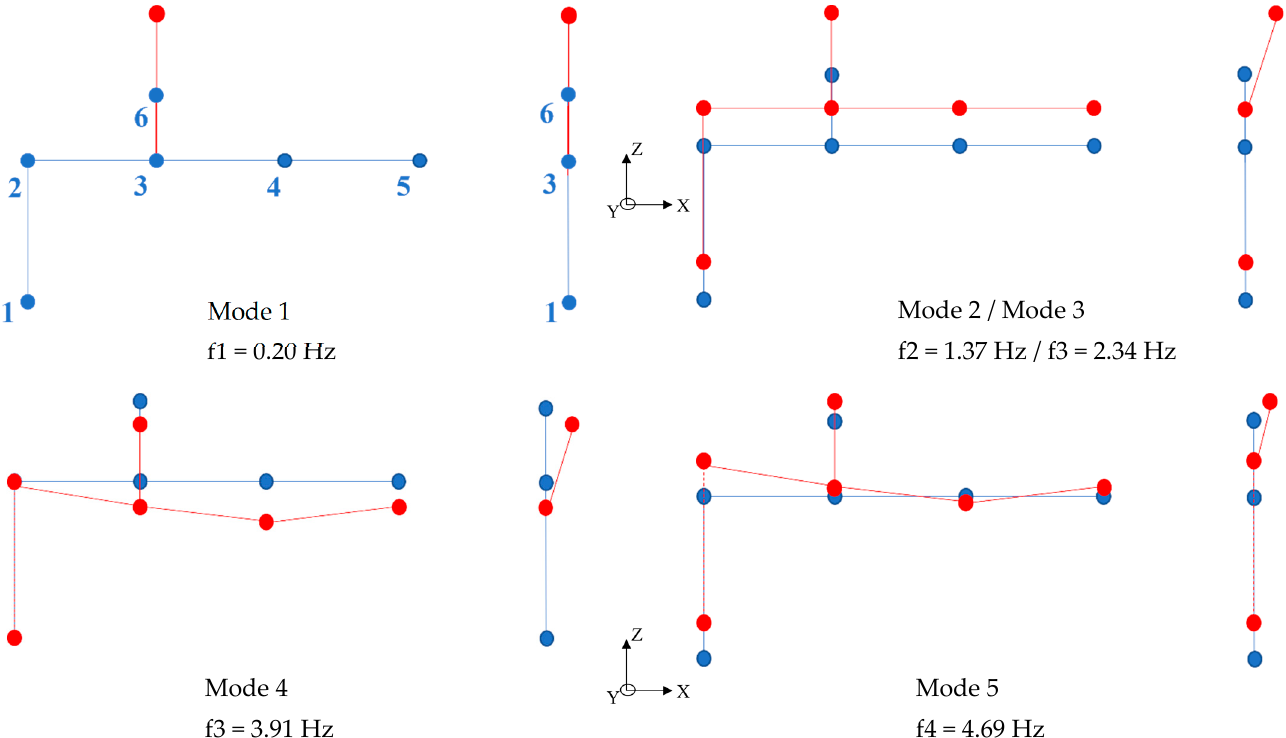
Figure 12. AP standard seat experimental modal parameters, where the front and lateral views are presented.